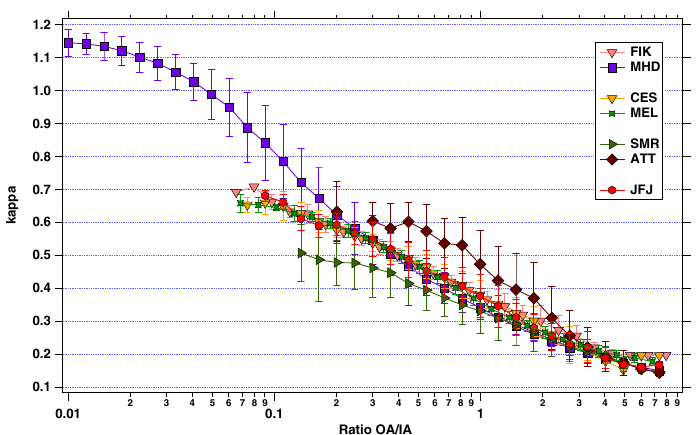
Figure 9. Relationship of the composition-derived hygroscopicity parameter, κ , to the binned and averaged ratio of organic (OA) to inor- ganic (IA) aerosol components. The vertical bars denote the standard deviation. Note that the asymptotic-like approach of the curves towards a κ value higher than 0.1 cannot be interpreted as κ being larger than 0.1 for these sites, because κ = 0.1 was used as assumption to derive the κ values shown on the y -axis. Note that the standard deviation for the lowest OA / IA ratios at FIK are so small that they do not go beyond the